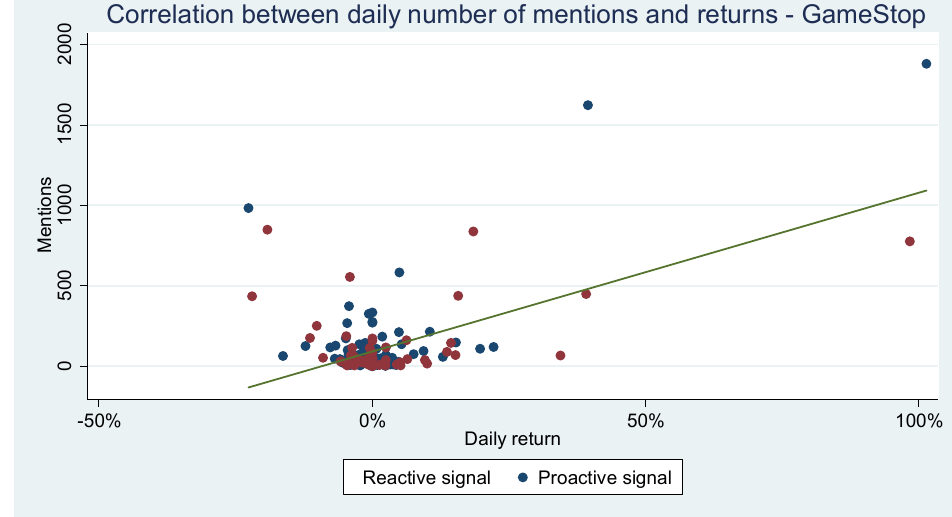
Figure 6. Correlation between the number of mentions and daily return of GameStop.